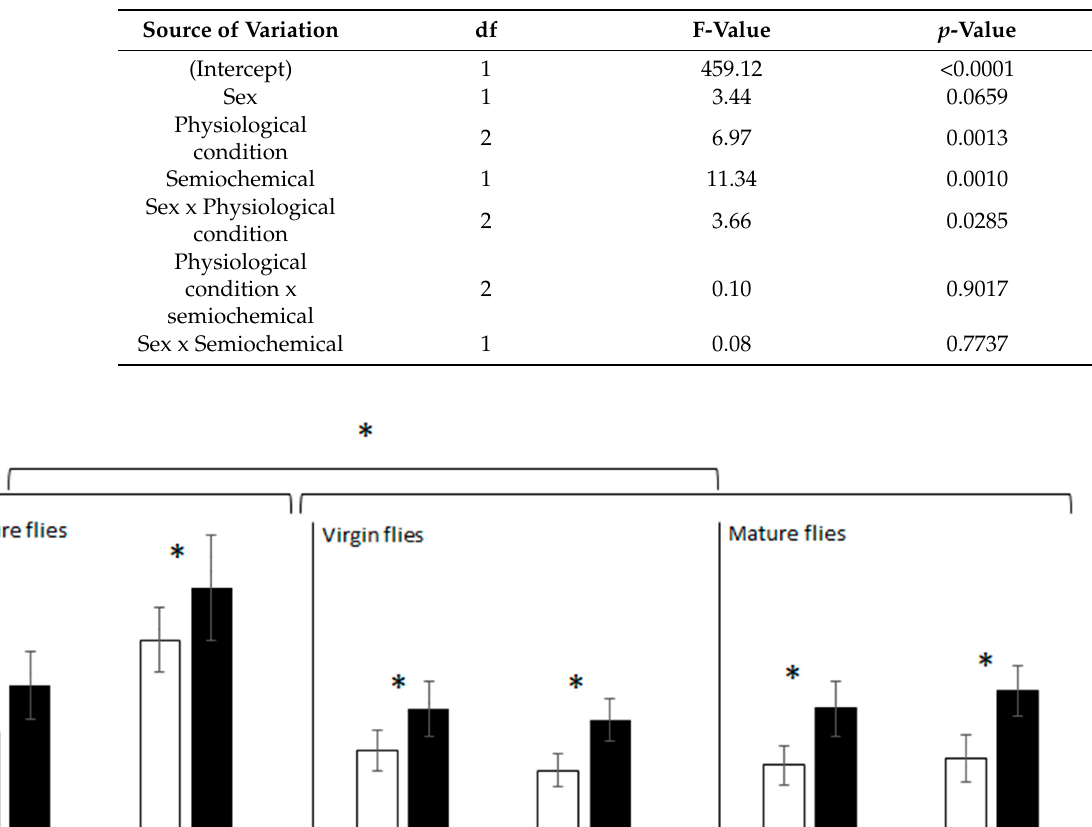
Table 1. Results of the general lineal model built to analyze the antenna response (amplified signals expressed as mV) of A. fraterculus to the semiochemicals according to their sex (male or female) and physiological condition (age and mated status).